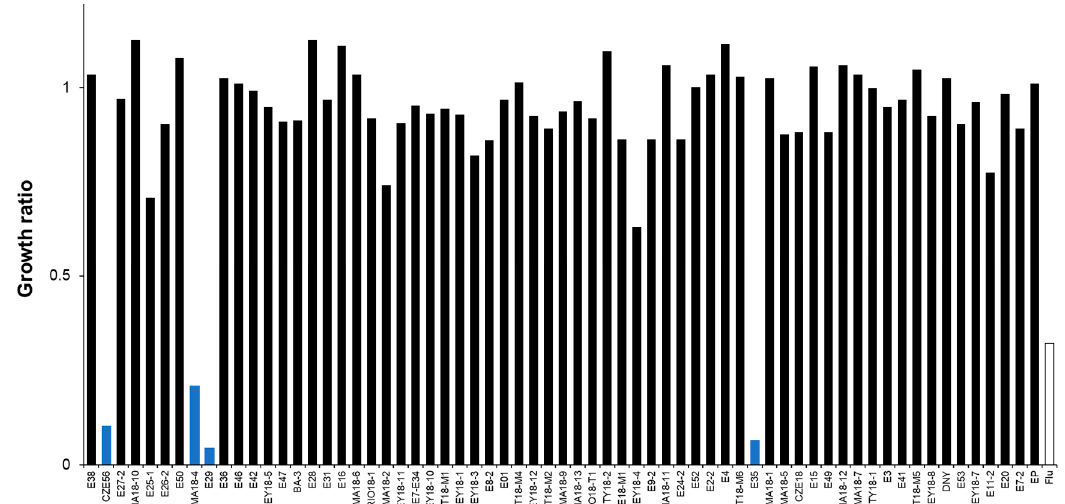
Figure 3. Susceptibility of C. albicans to marine extracts from the Yucatan Peninsula. Growth was monitored after 48 h of incubation at 30 °C. Growth ratios were determined in comparison to control (untreated) cells. Fluconazole (a triazole antifungal) was used as a reference antifungal (0.5 µg/mL). Growth ratios below 0.5 indicate active extracts (blue bars). Table 1. Marine crude extracts tested for antifungal activity.